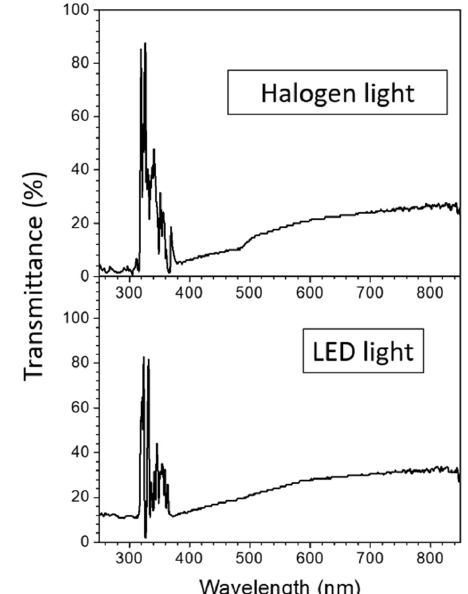
Figure 5. UV-vis spectra of each polymeric sample.